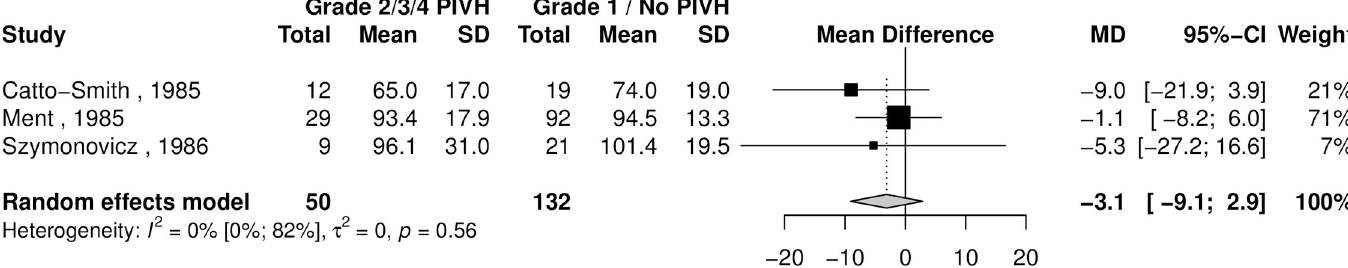
Fig 2. Absolute mean difference of mental development index between children with no or grade 1 peri-intraventricular haemorrhage (PIVH) and children with higher degrees of